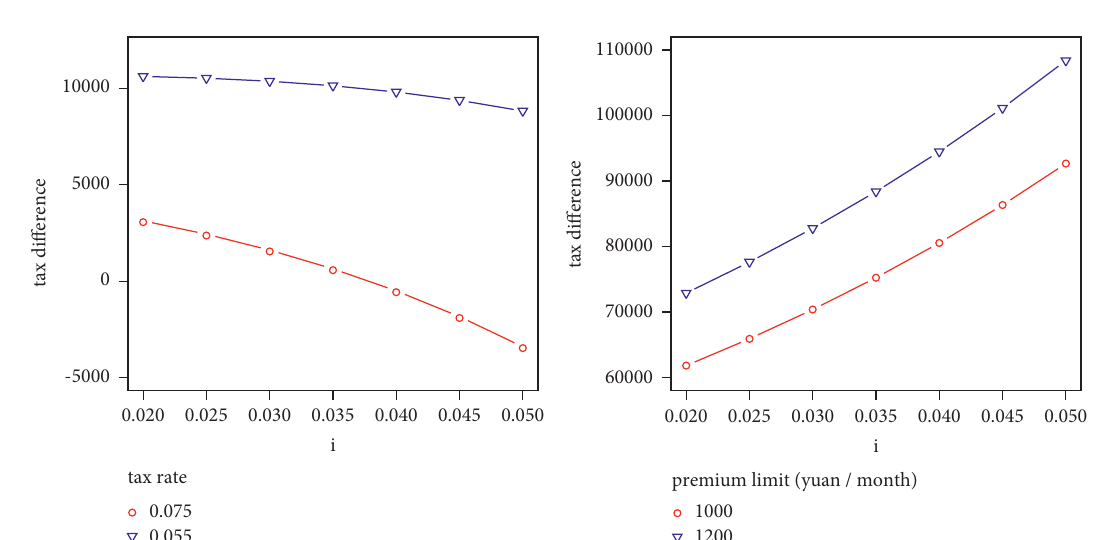
Figure 4: Tax difference under different predetermined interest rates.